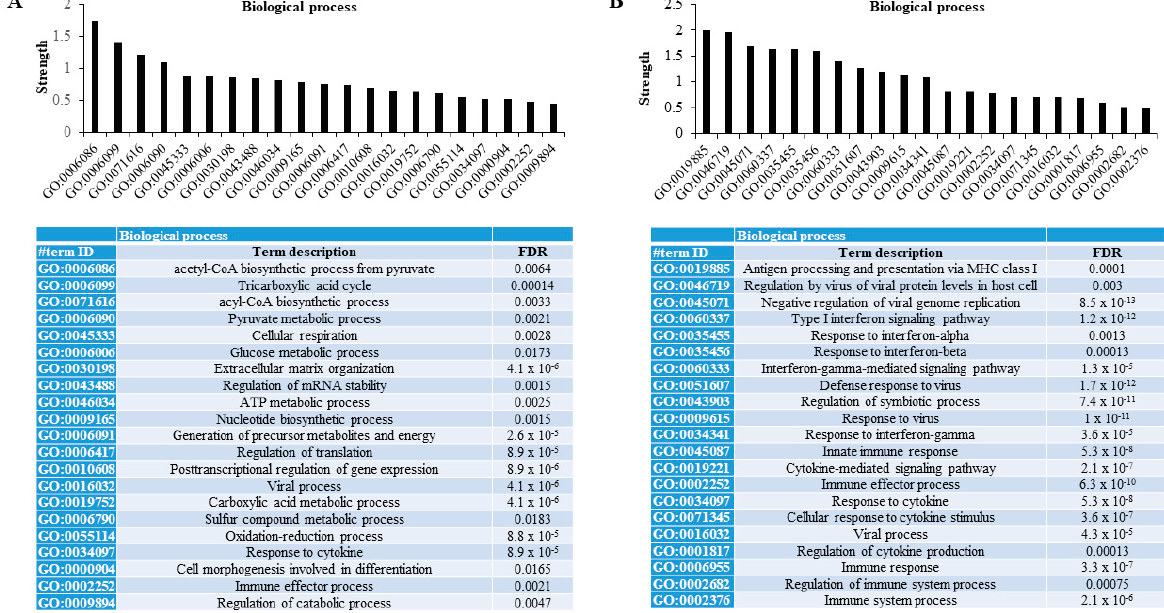
Figure 2. Proteomic persulfidation networks analysis. Analysis of functional protein association net- works using STRING database of differentially decreased ( A ) and increased ( B ) persulfidated proteins in siRNA_MIX- compared to siRNA_SCR-treated cells. FDR, false discovery rate adjusted p value.